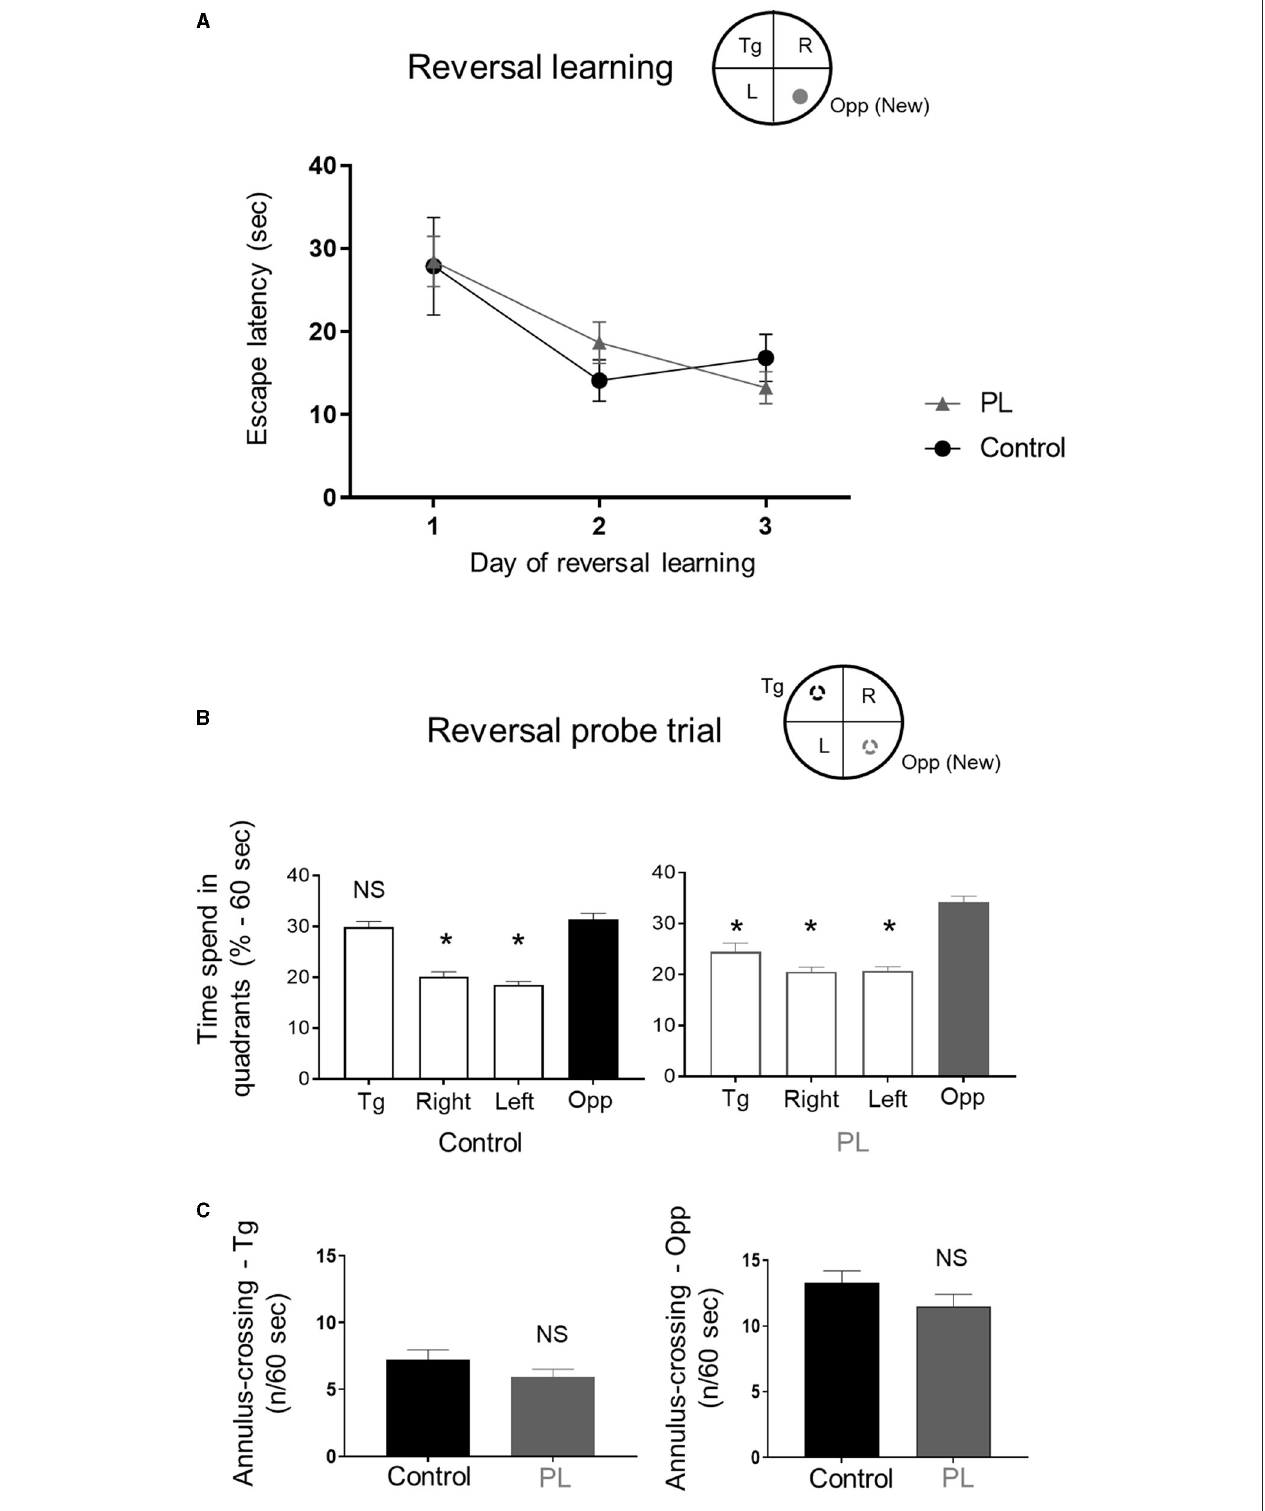
FIGURE 2 | Reversal long-term memory. Animals supplemented with polar lipids (PL) showed similar learning performances than control animals during (A) the reversal learning as shown by the decreased time to find the new escape platform. (B) During the reversal probe trial, the time spend by PL animals in the new target quadrant (Opp) was significantly higher than the other quadrants (left panel) while control animals spend a similar amount of time in both the new (Opp) and old (Tg)